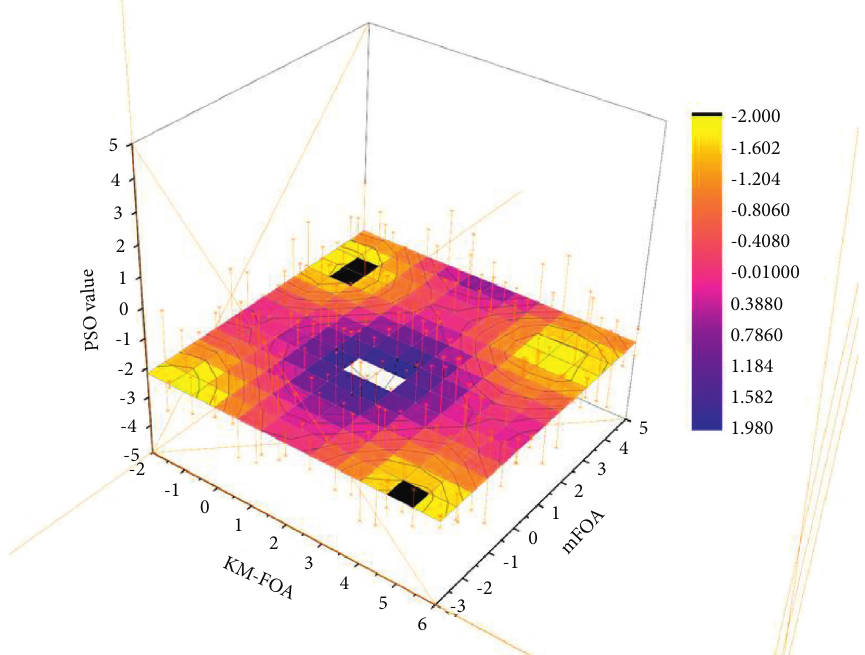
Figure 4: Benchmark function optimization test